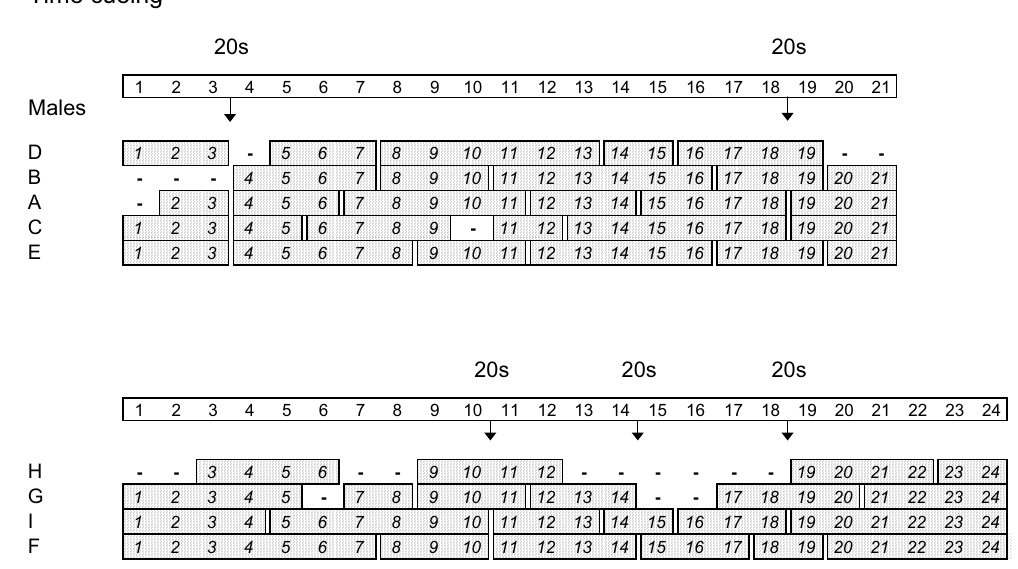
Fig. 3 – Imitations (italic numbers) and their sequential associations (song-packages, stippled areas) developed by the birds A-E and F-I from the stringsT1 andT2 presented in the experiment ‘time cueing’.Arrows indicate the sequential locations where two successive songs were segregated by 20s (instead of 4s) and where package boundaries were expected if cueing occurred. Acquisition failures are given by